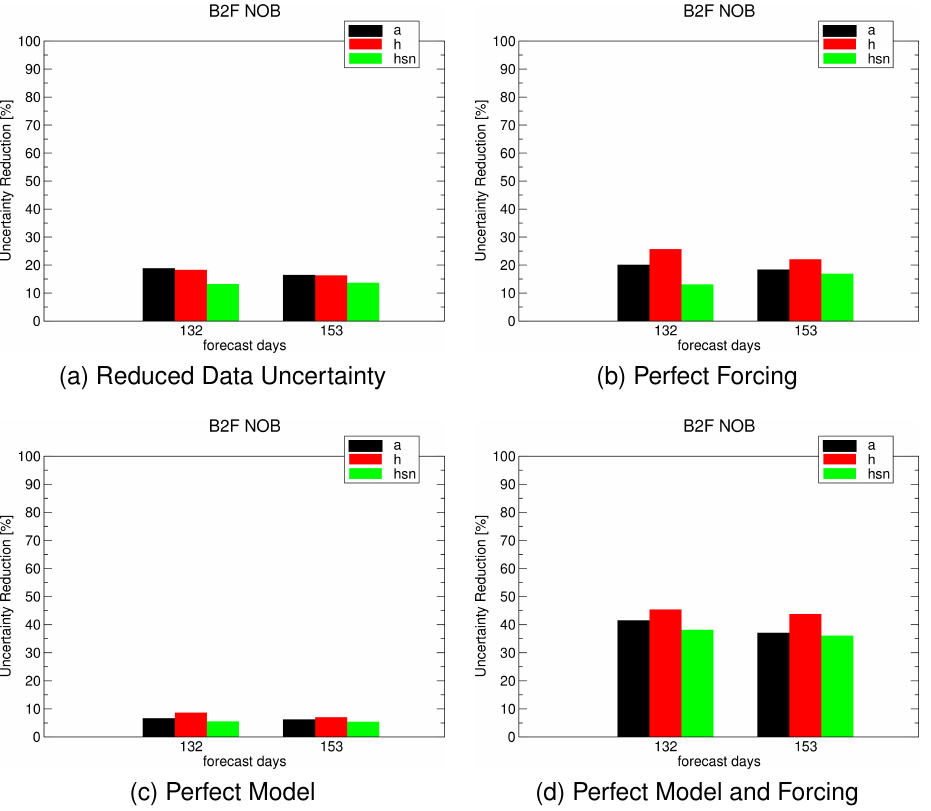
Figure 12. Uncertainty reduction for target areas NOB for flight transect B2F with data uncertainty of 0.1 m (panel a ), the assumption of perfectly known atmospheric forcing (panel b ), the assumption of a perfectly calibrated model (panel c ), the assumption of perfectly known atmospheric forcing and of a perfectly calibrated model (panel d ).